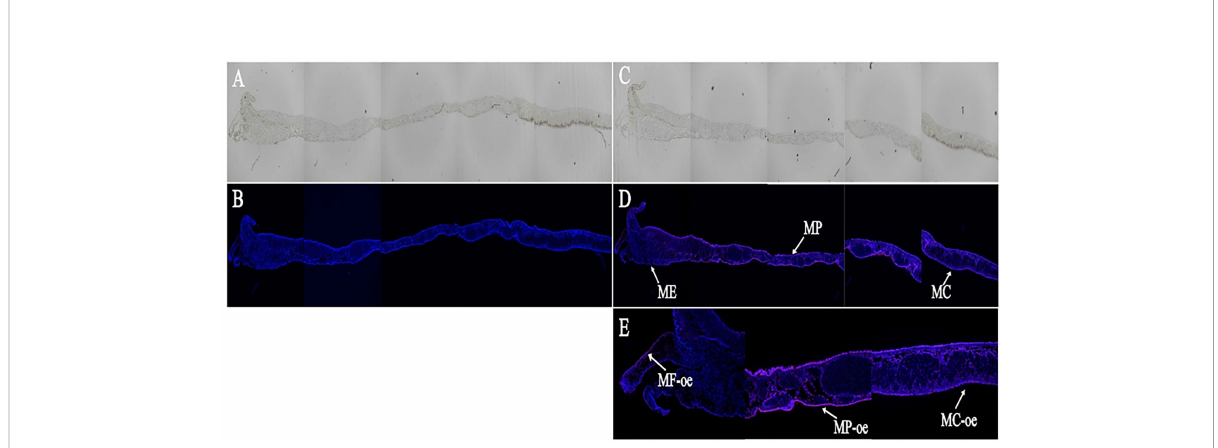
FIGURE 4 The in situ hybridization results of LncMPEG1 in the outer epidermal cells of the mantle. (A, B) control group; (C, D) experiment group; (E) the local enlarged mantle tissue of the experiment group; (A, C) general observation; (B, D, E) fl uorescence observation; ME, mantle edge; MP, mantle pallial; MC, mantle center; MF, middle fold; and oe, outer epithelium. The red fl uorescence and arrow indicate the in situ hybridization signal of LncMPEG1 ; the blue fl uorescence indicates the